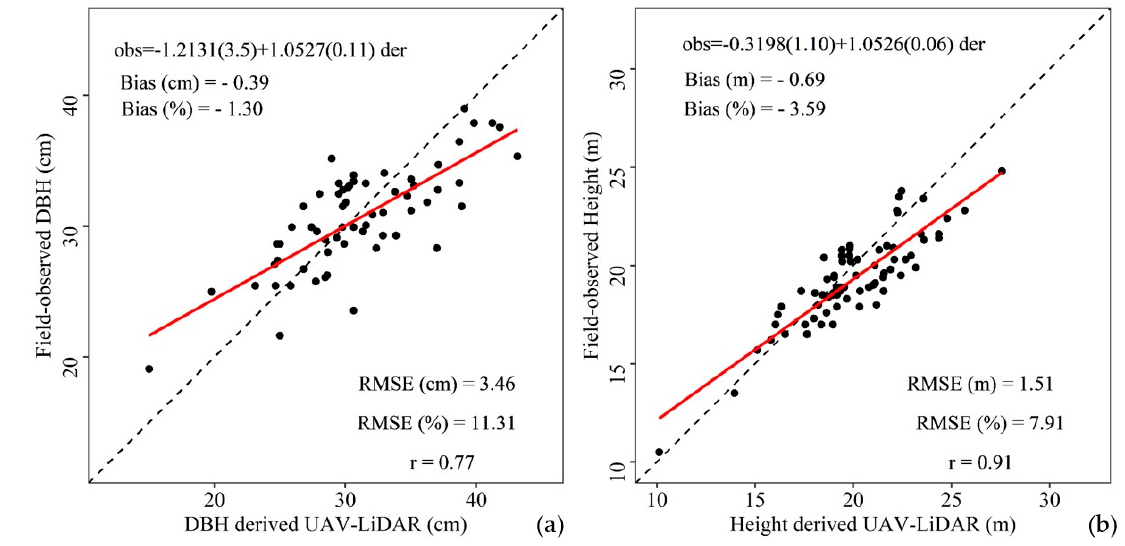
Figure 5. Linear relationship between Field-observed and derived UAV-lidar in the integrated crop-livestock-forest system (ICLF) in Brazil. ( a ) Field-observed dbh and derived UAV-lidar; ( b ) field-observed height and derived UAV-lidar. The dashed line represents the 1:1 correspondence.